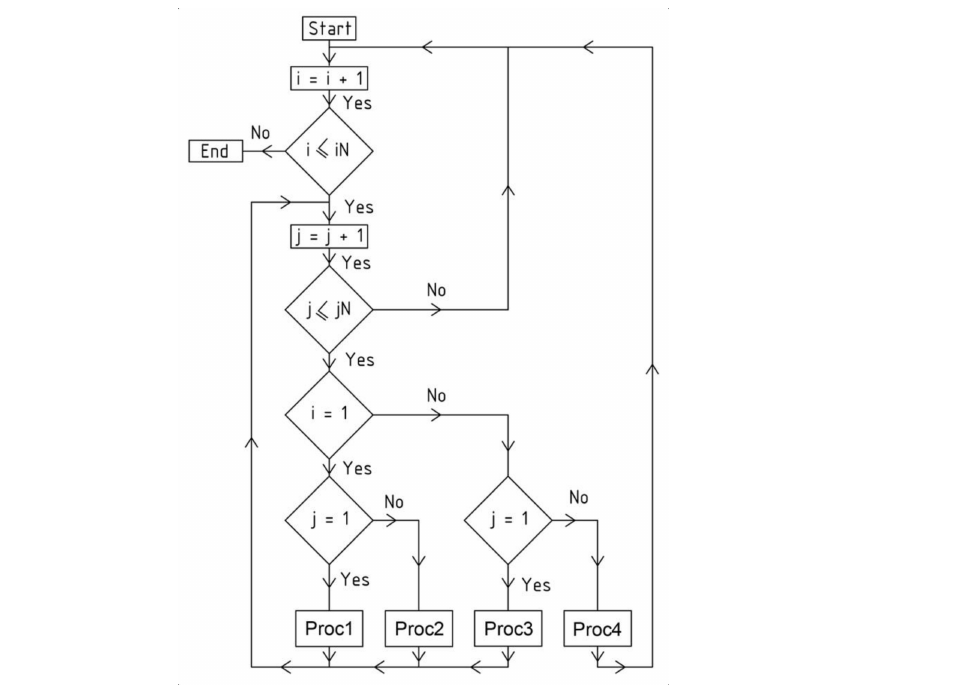
Figure 11. The algorithm of the iterative process for creating the nets Γ and B v and structures Ω and ∑ .